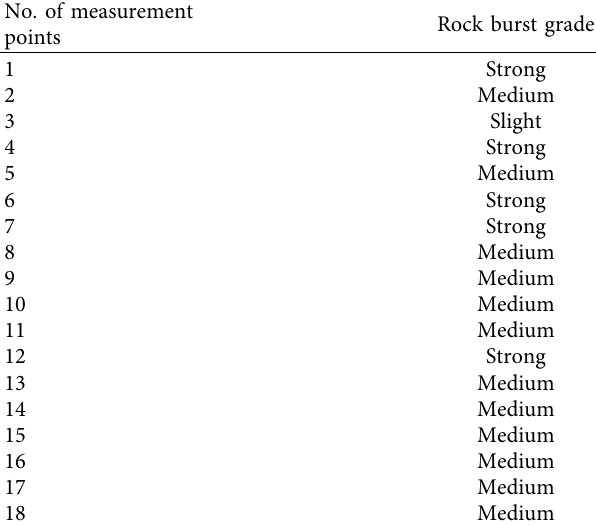
c to σ max in CHEGI